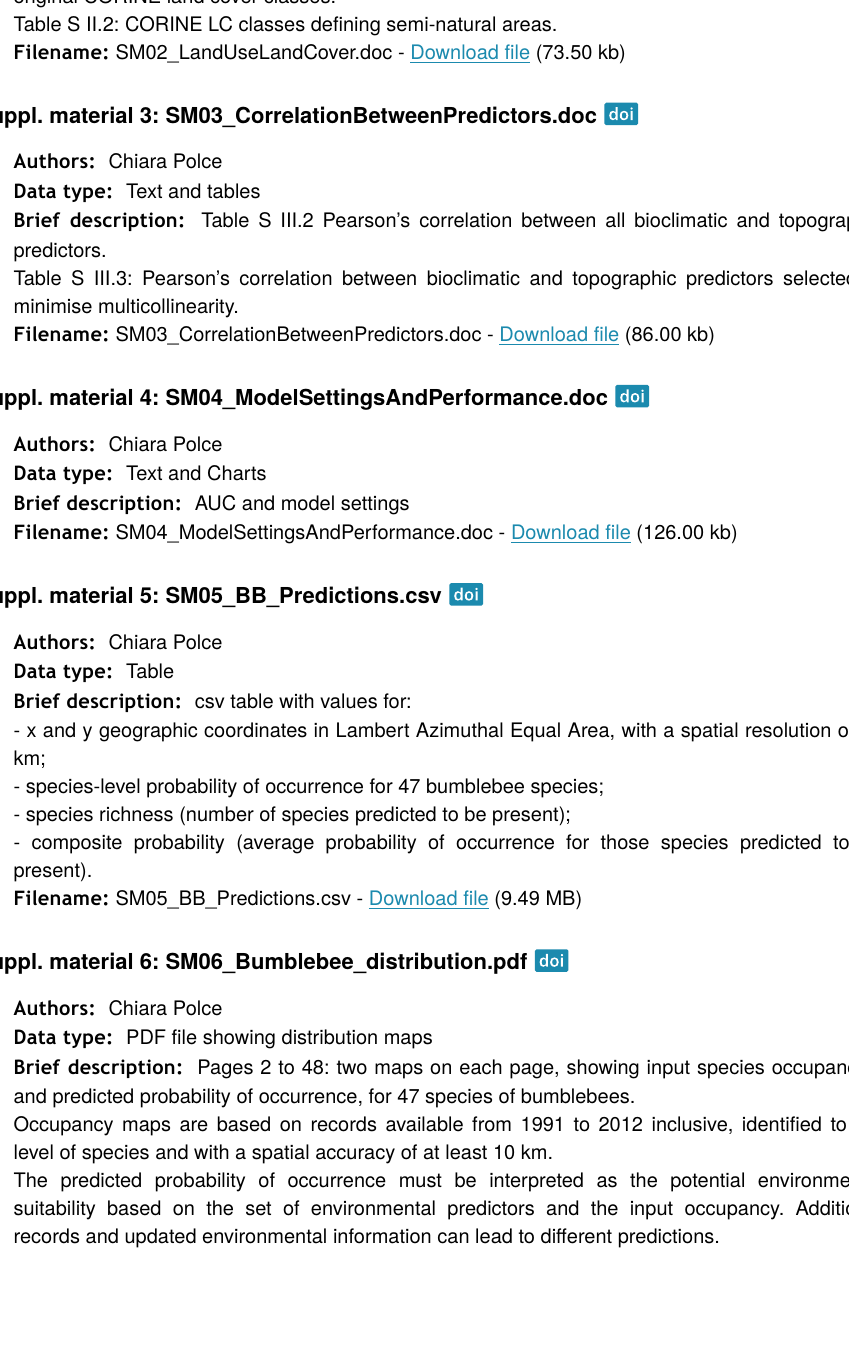
Table S II.2: CORINE LC classes de fi ning semi-natural areas.